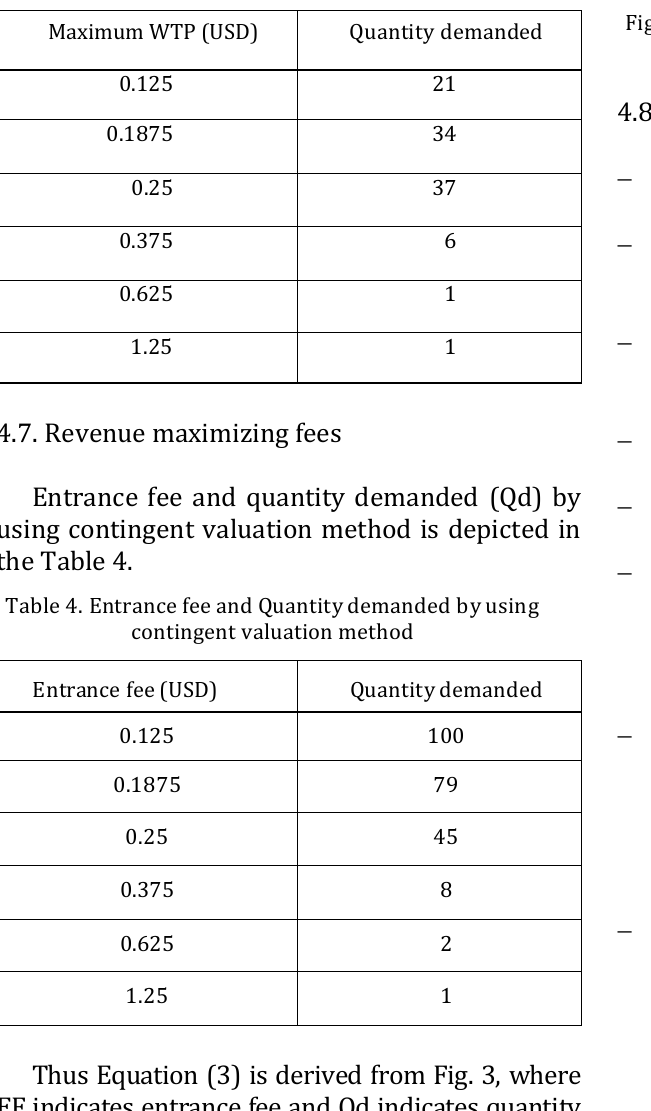
Table 3. Maximum Willingness to pay and Quantity